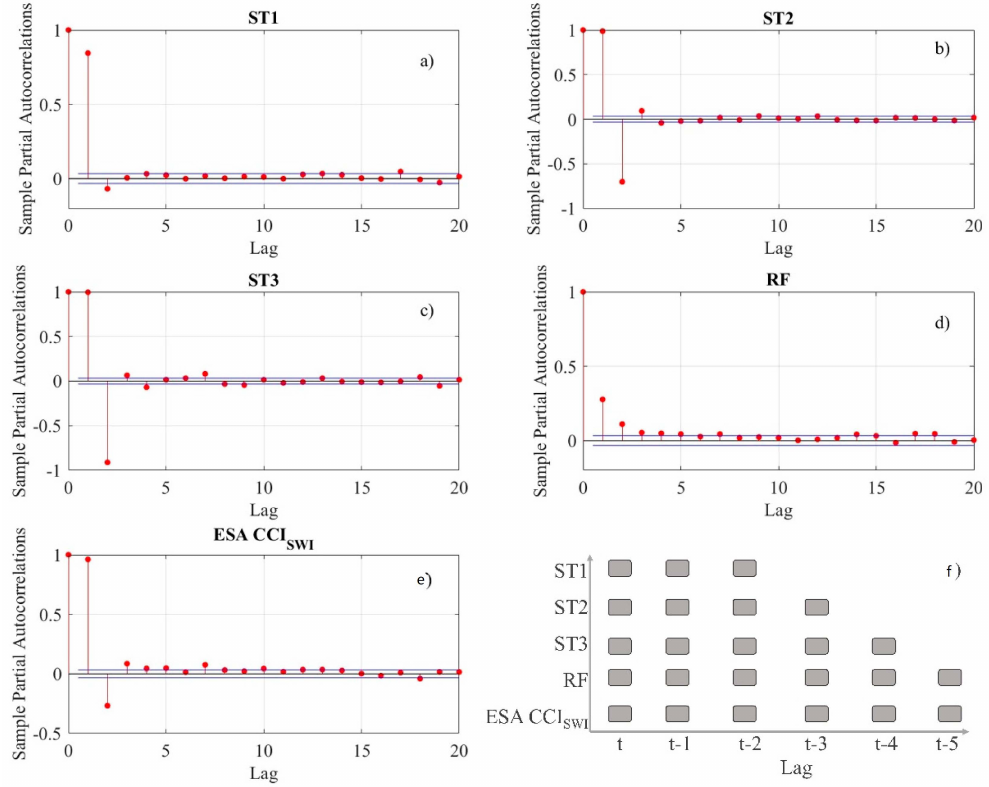
Figure 9. The partial autocorrelation function of the input variables ( a – f ) and their time lags considered in this study ( f ). STn, RF, and ESA CCI SWI represent the n-th tank storage in the tank model, rainfall, and root-zone European Space Agency (ESA) CCI SM data, respectively. The solid blue line represents partial autocorrelation along with the 95% confidence interval for a white noise process. Values outside of the confidence interval are statistically